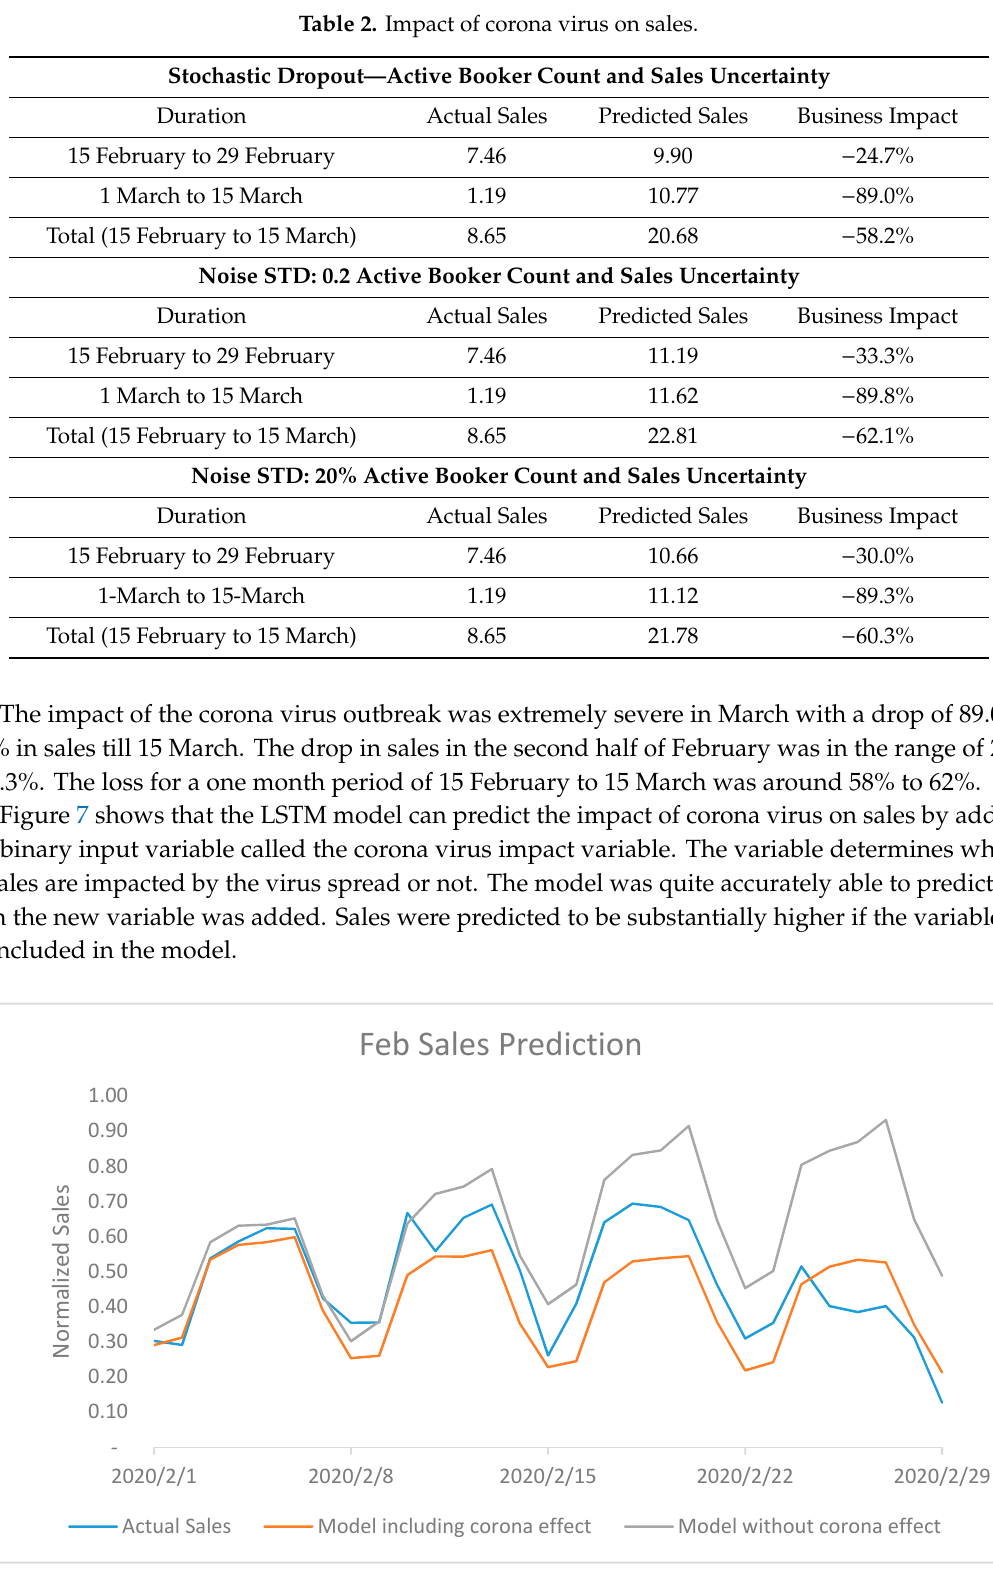
Figure 7. Model predictions with and without the corona virus impact.